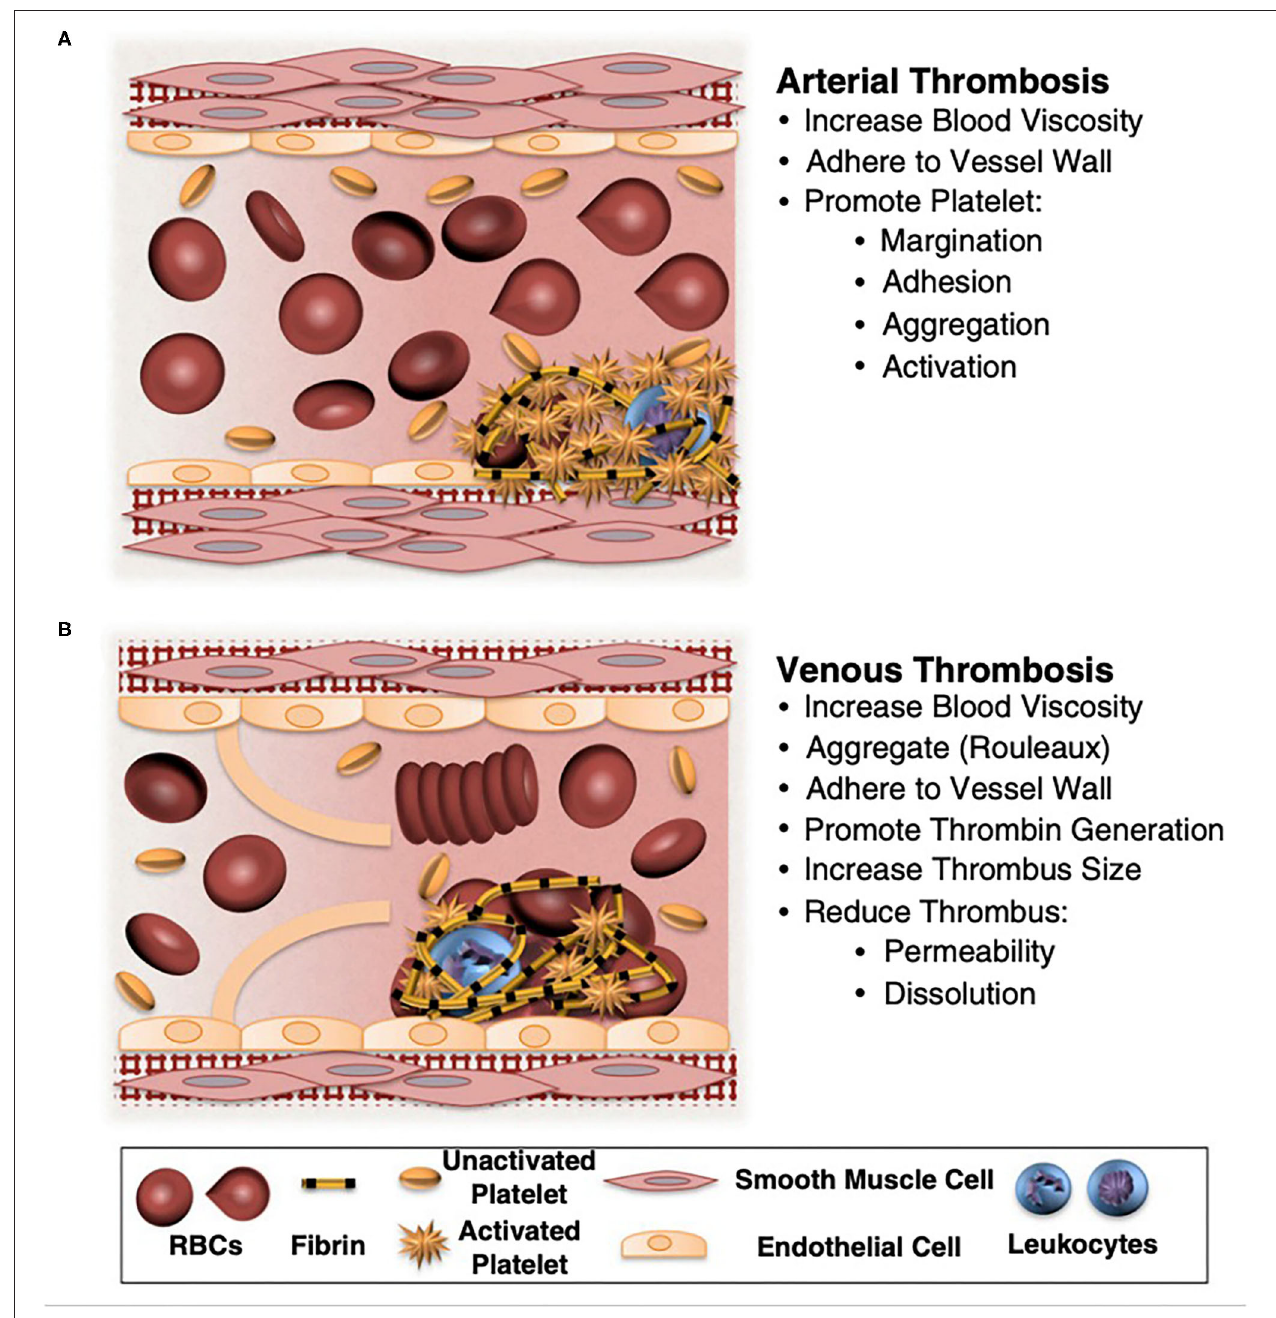
FIGURE 1 | Potential contributions of normal and abnormal RBCs to arterial and venous thrombosis/thromboembolism. (A) Arterial thrombi arise in vessels with high shear rates, which promotes the rapid formation of platelet-rich thrombi. During arterial thrombosis, RBCs promote platelet margination, increase platelet-thrombus interactions, and enhance platelet adhesion and activation. Although RBCs increase blood viscosity, this effect is lessened in arteries by high shear-induced shape change. (B) Venous thrombi form slowly in stasis or low flow (frequently in venous valve pockets) and are RBC and fibrin rich. In veins, RBC aggregation into stacked rouleaux structures increases blood viscosity. RBCs can also directly or indirectly adhere to the vessel wall and may contribute to thrombin generation within thrombi. Once incorporated into venous thrombi, RBCs increase thrombus size and reduce thrombus permeability and susceptibility to lysis. In disease states, abnormal RBCs and RBC-derived microvesicles may also adhere to the endothelium or extracellular matrix, activate platelets and other cells, and enhance local thrombin generation during thrombosis. Adapted with permission from Byrnes and Wolberg (2).